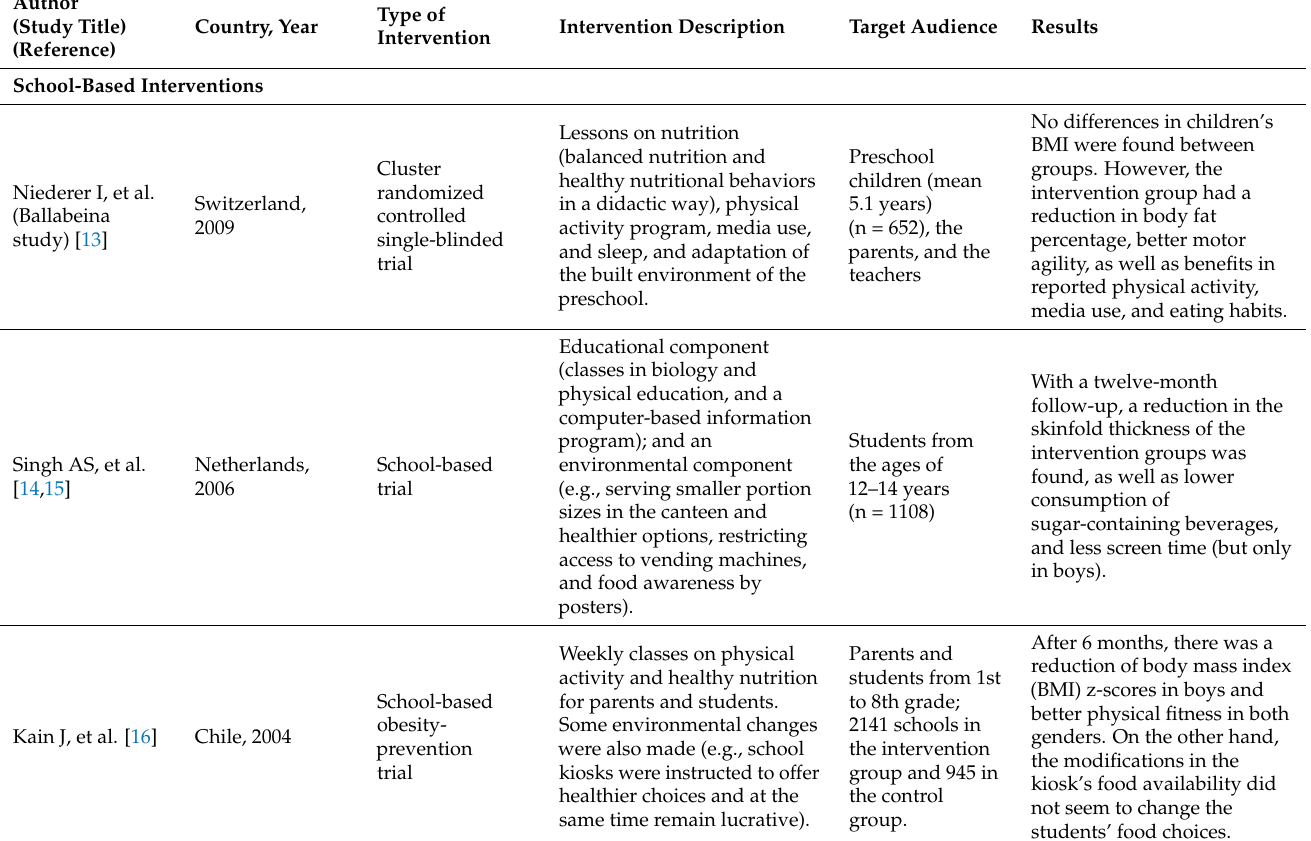
Table 1. Summary of dietary interventions on childhood obesity and their main characteristics and